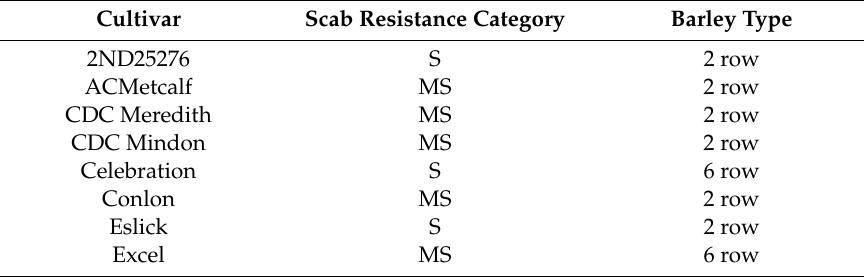
Table 1. Observed barley varieties and associated DON resistance